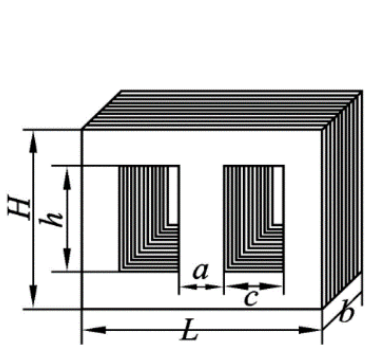
Figure 1. Transformer core. Table 1. Parameters of the tested